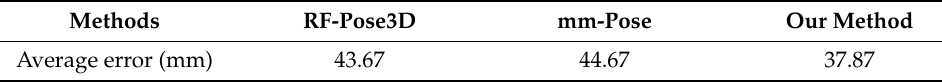
Table 2. Detection performance comparison.